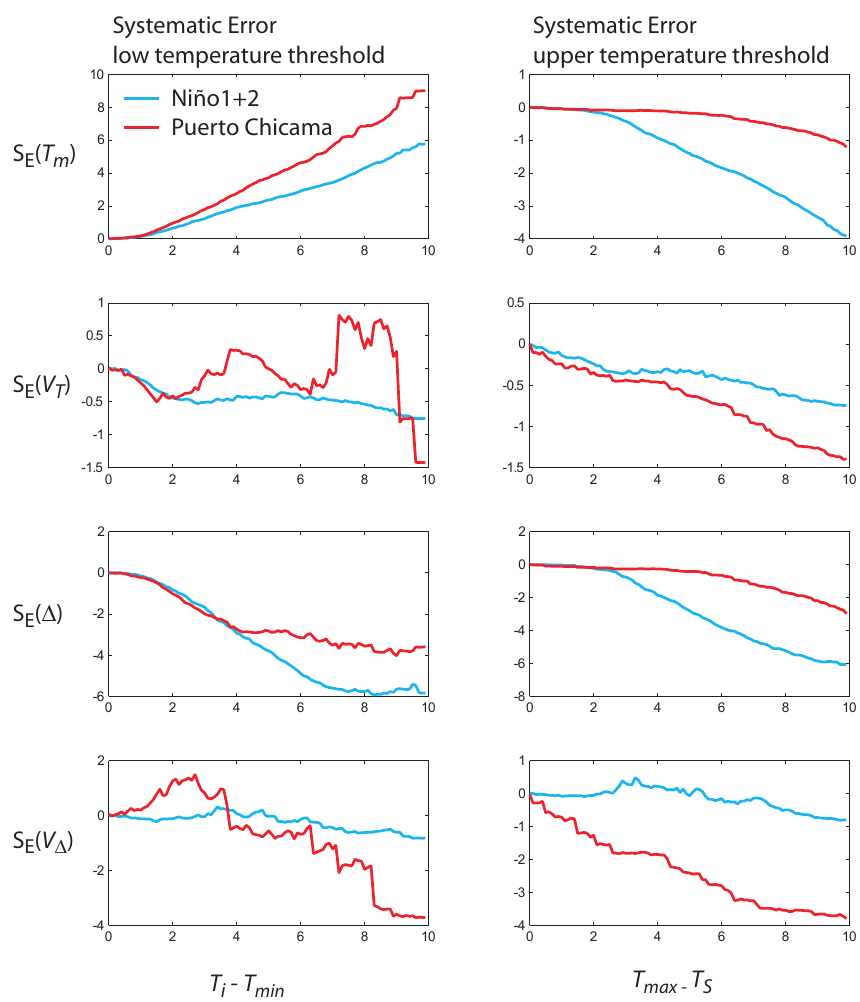
Fig. 6. Results of experiment 5. Systematic errors for T m , V T , 1 , and V 1 due to growth temperature limits. The effects of inferior (superior) temperature limits are shown on the left (right). In the upper panels are indicated the temperature ranges of Ni˜no1+2 SSTs (blue) and Puerto Chicama SSTs (red). The darker intervals show the range of temperature recorded by the archive limited by T I (left panels) and T S (right